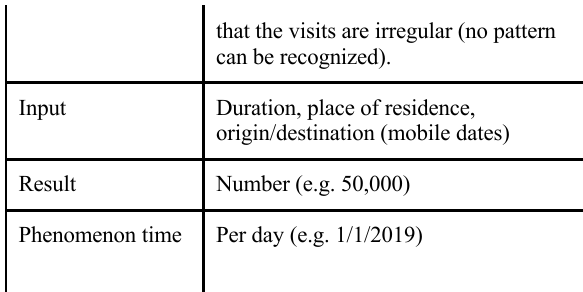
Table 6. Description of the profile “Random staying visitor”.